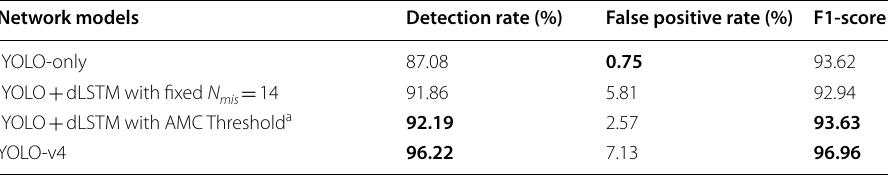
Bold indicates better results